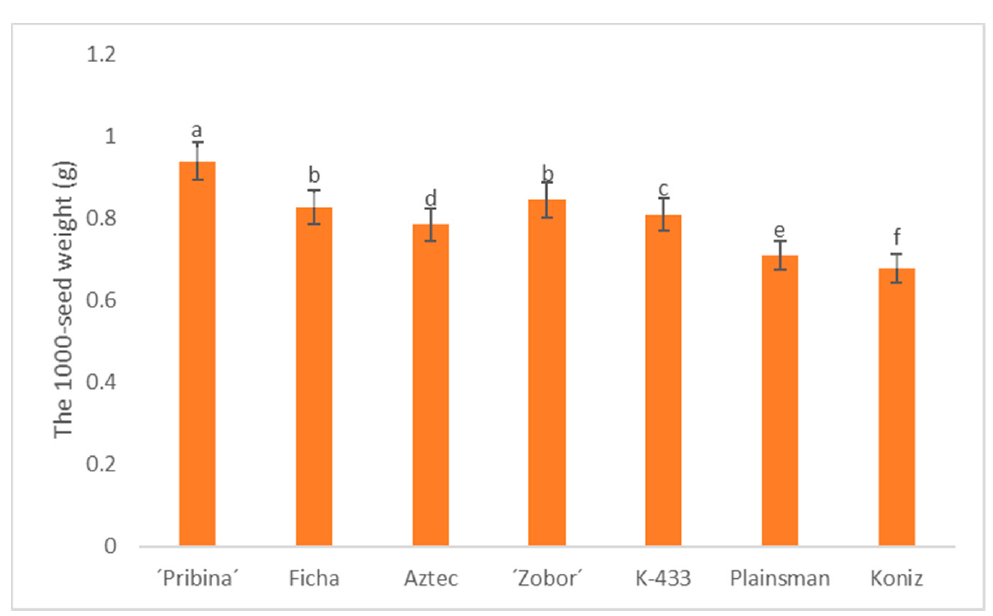
Figure 1. Comparison of 1000-seed weight over a three year period (2016–2018) in amaranth samples. Results are the means ( ± SE; standard error) for three growing seasons of three independent biological replicates per each variety per year. Di ff erent letters on bars indicate significant di ff erences by the Tukey test ( p ≤